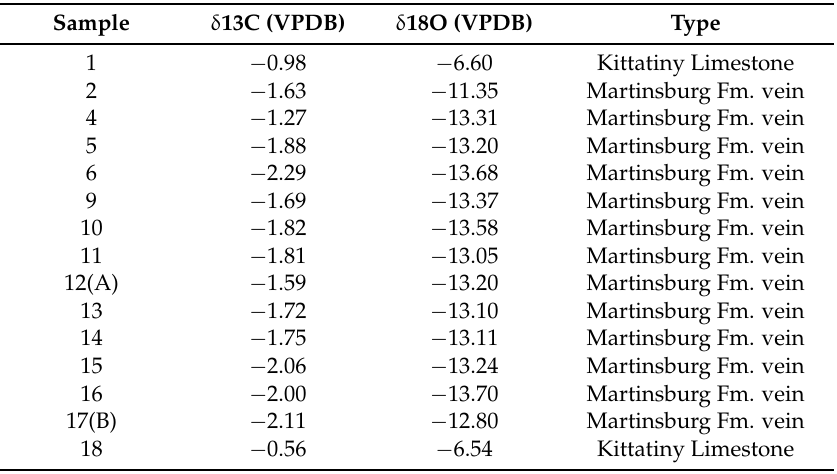
Table 1. Stone Church Syncline Stable Isotope